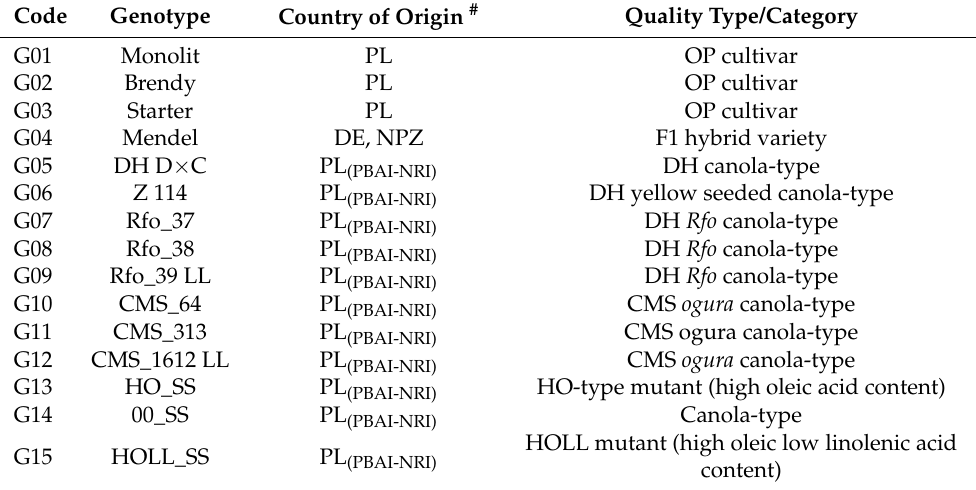
Table 1. Genotype